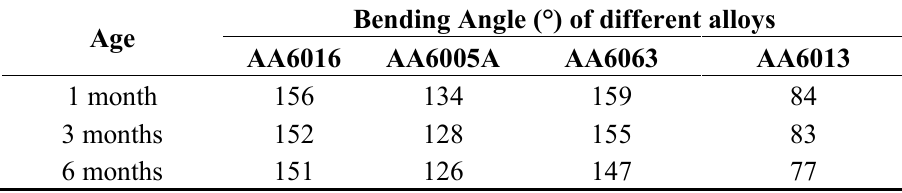
production in temper T4*.